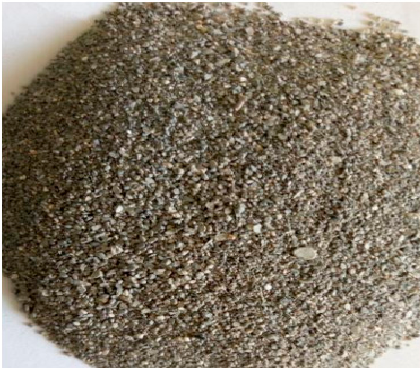
Figure 1. MRCG retained in sieve No. 200.